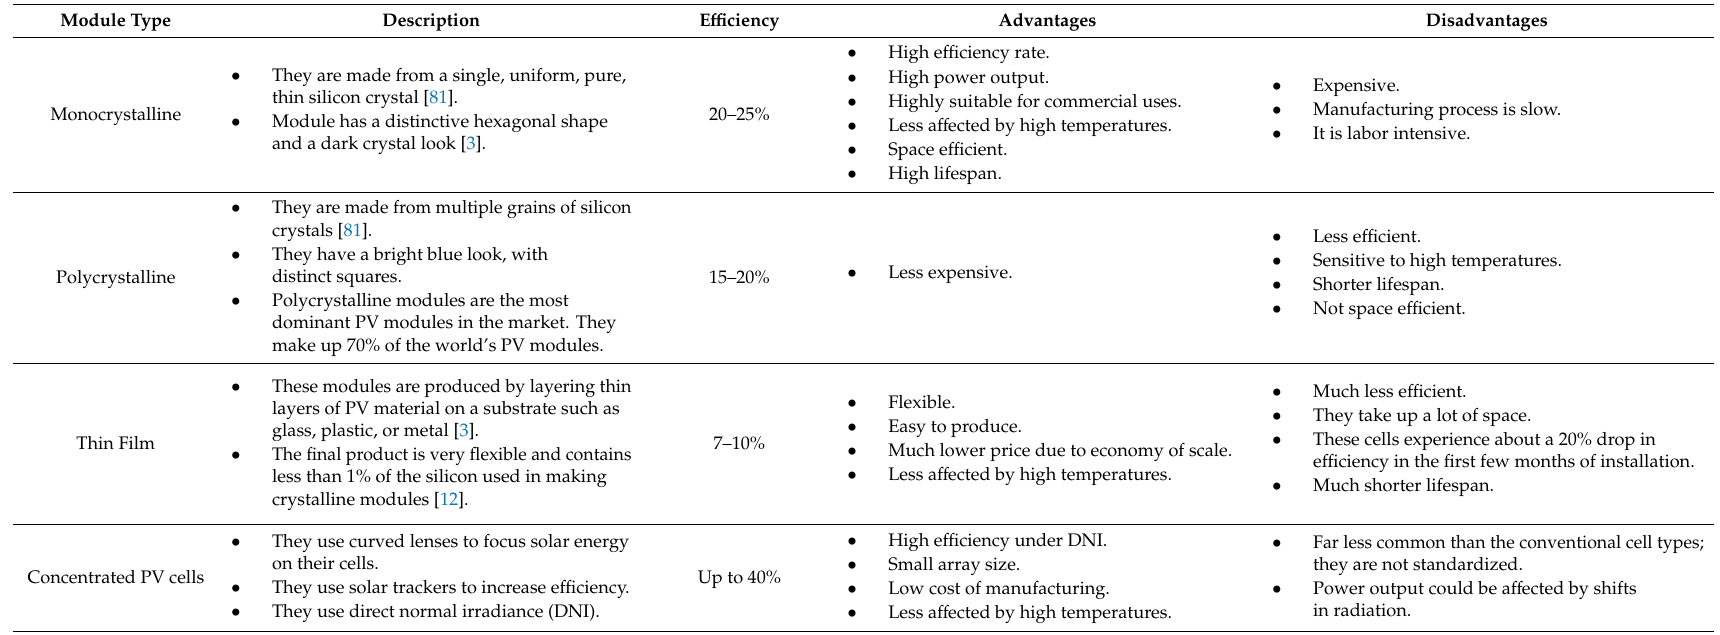
Table 2. Di ff erent types of PV-system